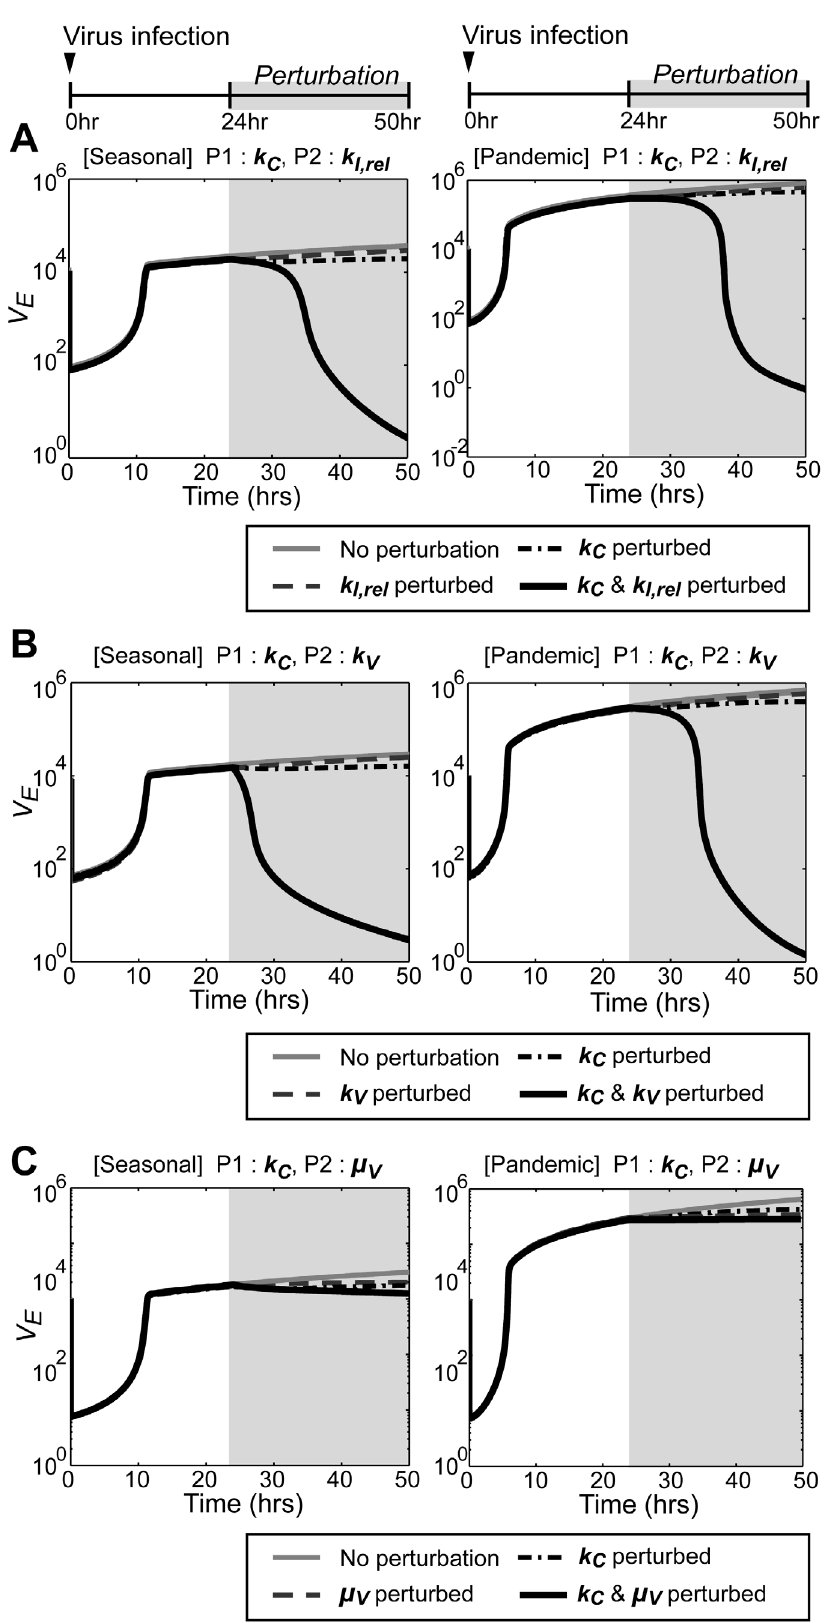
Figure 6. Inhibitory effect of combinatorial perturbations on the viral production of the seasonal and pandemic strains. ( A–C ) The perturbations were numerically performed 24 hours after infection. In addition to the 50-fold reduction of the k C value, a ten-fold increase of k I,rel (A)